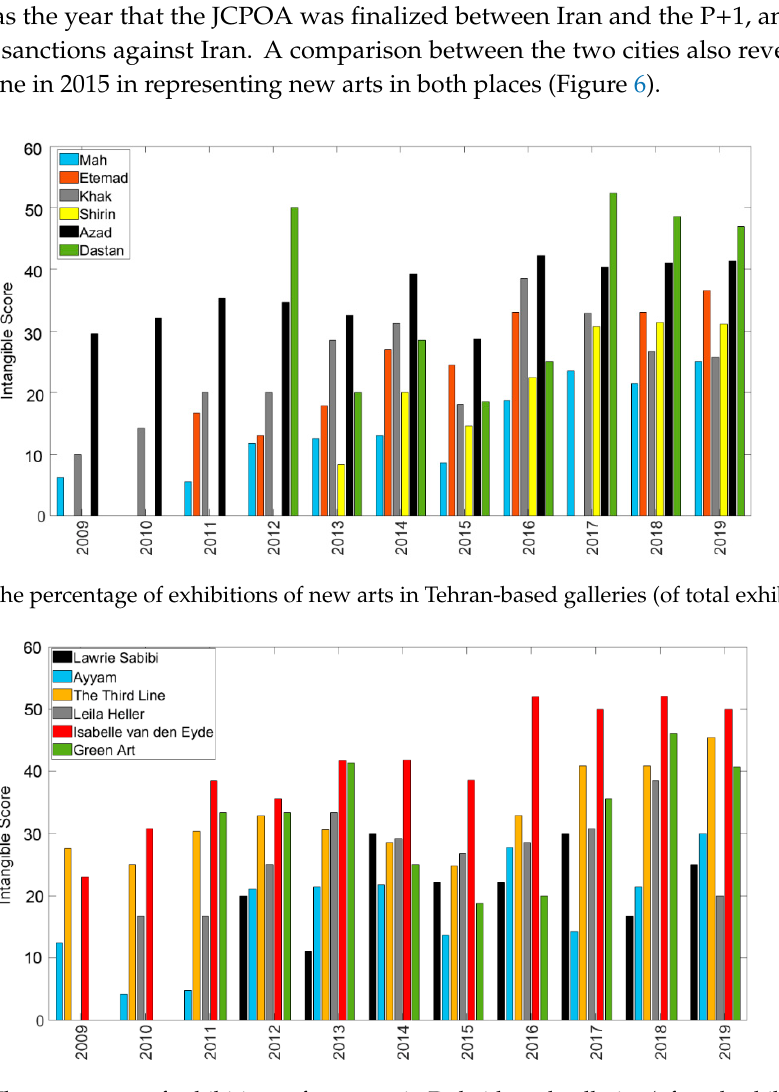
Figure 5. The percentage of exhibitions of new arts in Dubai-based galleries (of total exhibitions).